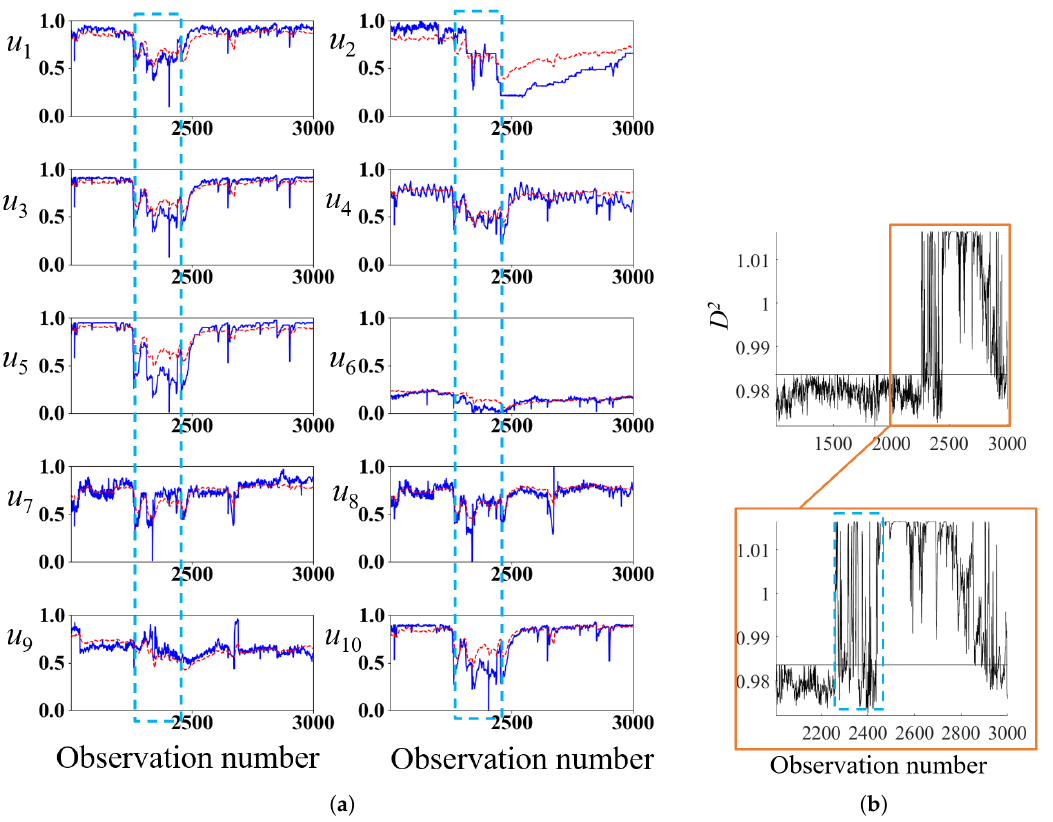
Figure 10. Prediction results using GRU and monitoring results using SVDD for Case 2. ( a ) Prediction results using GRU, ( b ) Monitoring results using SVDD.